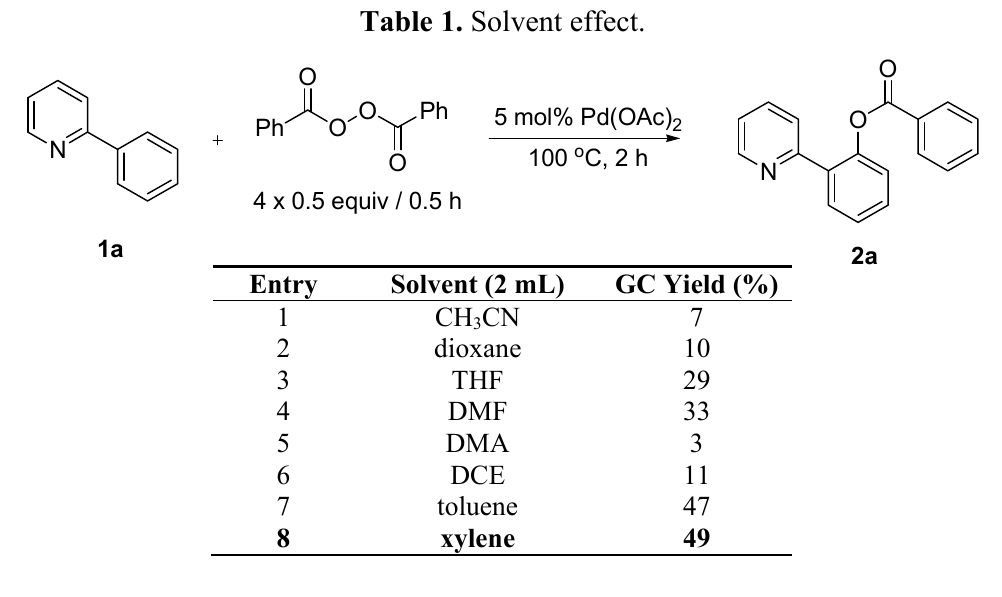
Table 2. Effect of other experimental